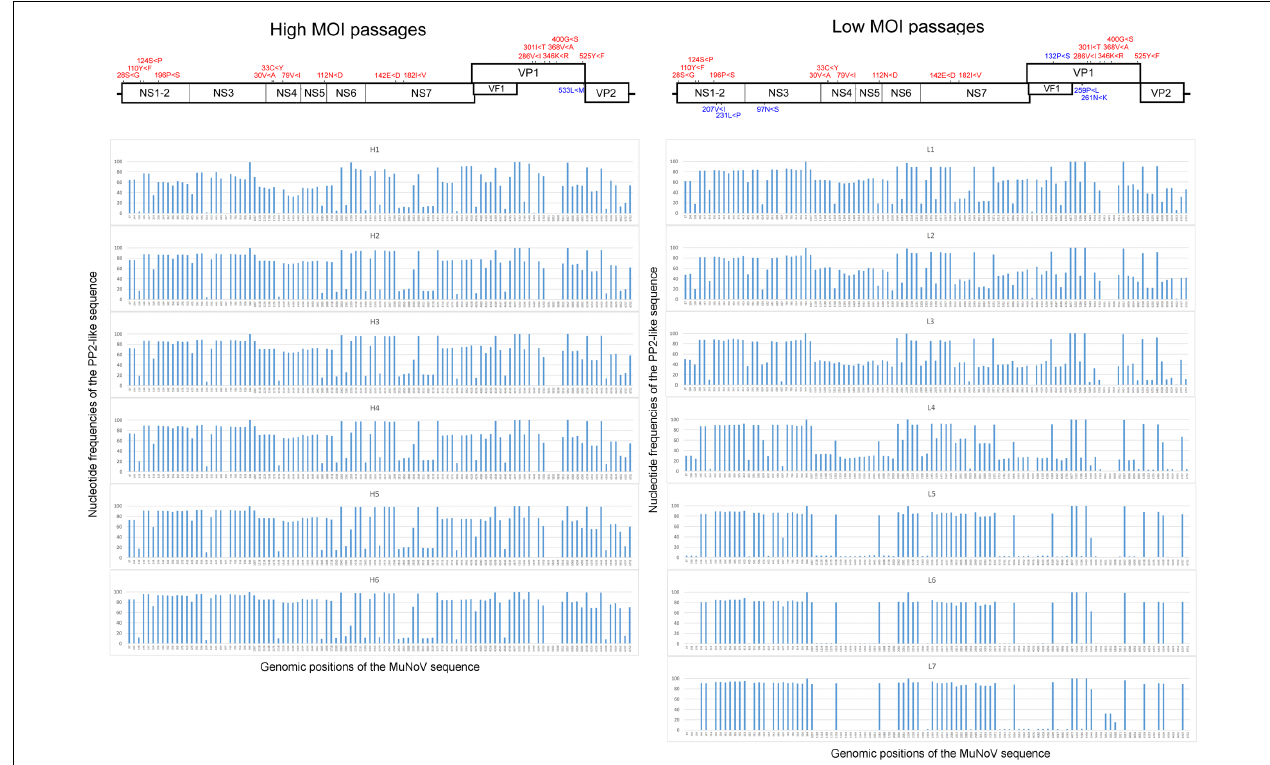
FIGURE 2 | Frequencies of nucleotide differences between the PP2 and PP3 sequences during MuNoV cell passage. Changes in PP2-sequence frequencies during high- and low-MOI passages ( Left and Right , respectively). The horizontal axis indicates the genomic position of the sequences, and the vertical axis indicates the nucleotide frequencies of the PP2-like sequence. Upper panels depict schematics of the MuNoV genome, with indications of non-synonymous nucleotide changes translated to amino acids. Numbers indicate amino acid position affected by the nucleotide variations, and capital letters flanking “ < ” represent amino acids encoded by PP3 or PP2 sequences, respectively. Letters in red are common changes observed between the high- and low-MOI passages, and those in blue represent changes unique between